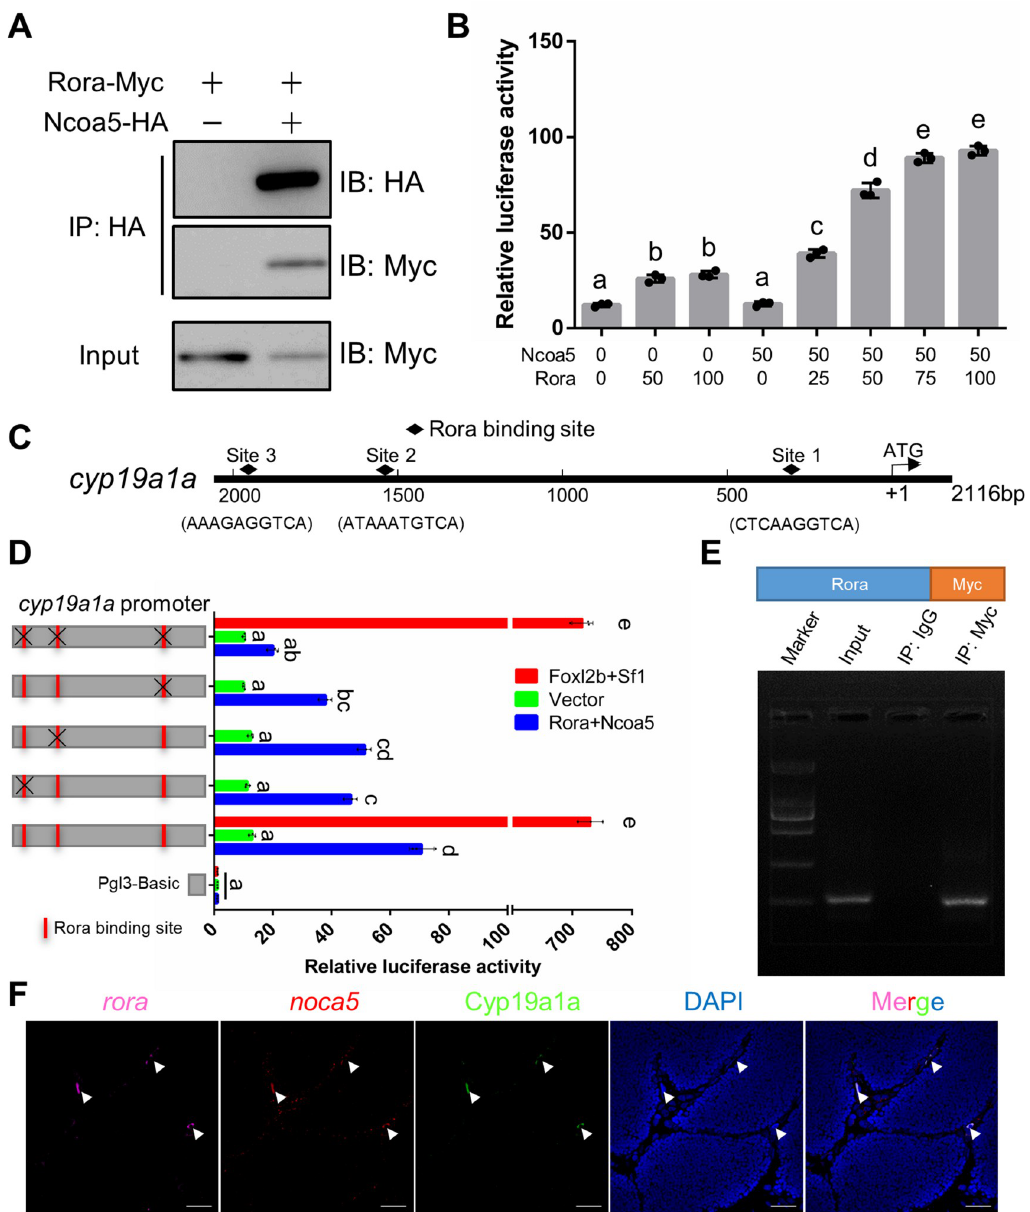
Fig 7. Rora interacts with Ncoa5 to regulate the transcriptional activity of cyp19a1a . (A) Co-IP of Rora-Myc with Ncoa5-HA in CAB cells transfected with the indicated plasmids. Anti-HA Ab was used for Co-IP. (B) In the presence of Ncoa5 (50 ng), Rora overexpression activates cyp19a1a promoter in a dosage-dependent manner in EPC cells. Different letters represent statistical differences ( P < 0.01). (C) Putative Rora cis -regulatory elements in the potential promoter of cyp19a1a . (D) 5 0 -mutation mapping of Rora-binding region on the cyp19a1a potential promoter. Red boxes indicate predicted Rora binding sites. Black ‘X’ indicates the mutated binding site. Different letters represent statistical differences ( P < 0.01). (E) ChIP-PCR assay in CAB cells transfected with Rora-Myc vector. Specific primers were used to amplify the fragment spanning the Rora binding site on the cyp19a1a promoter. The PCR products were detected by 1.5% agarose gel electrophoresis. IgG antibody-based ChIP assay was used as a negative control. (F) FISH analysis of the rora (Pink) and ncoa5 (Red) mRNA, and immunofluorescence analysis of the Cyp19a1a protein (Green) in mature testis. Arrowhead indicates the somatic cells with expression of rora , ncoa5 , and Cyp19a1a. Scale bars: 25 μ m.